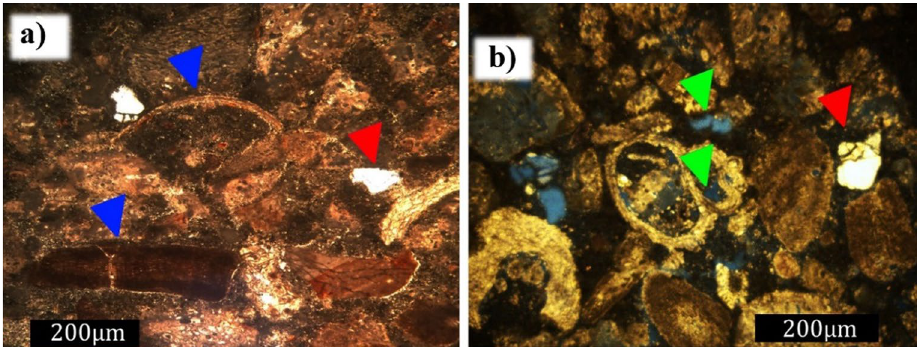
Figure 14. Micrograph obtained using a petrographic microscope (Nikon Eclipse POL) of crossed nicols of the synthetic carbonate rock ( a ) before and ( b ) after degradation, as well as the Halimeda green algae fragment (lower blue arrow) and a bivalve carapace (upper blue arrow).